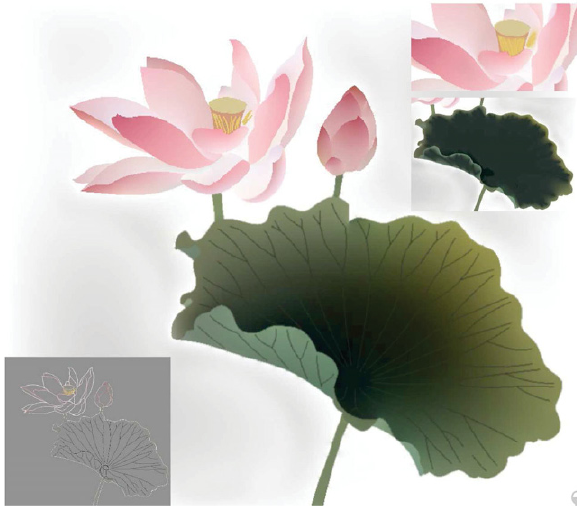
Fig. 4 Feature preservation capability of the DCC model. Main figure: lotus image generated by the DCC model, in which the yellow stamens of the lotus and the veins of the lotus leaf are clearly preserved. Insets, upper right: image from the Poisson model [1], in which the features of stamens and veins are not well kept. Inset, lower left: color